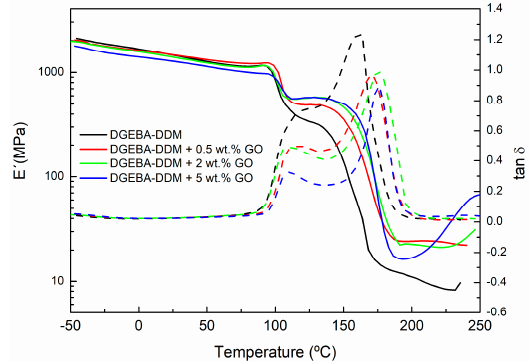
Figure 11. Storage modulus and tan δ of neat epoxy and composites with 0.5, 2, and 5 wt % of GO cured at a temperature of 90 °C.